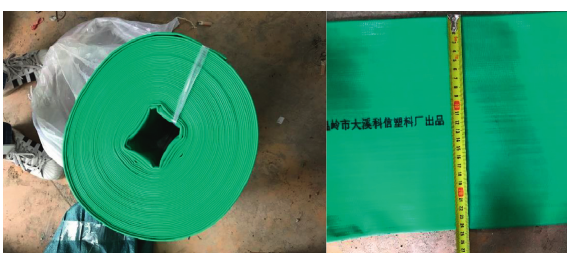
Figure 7: The plastic hose.